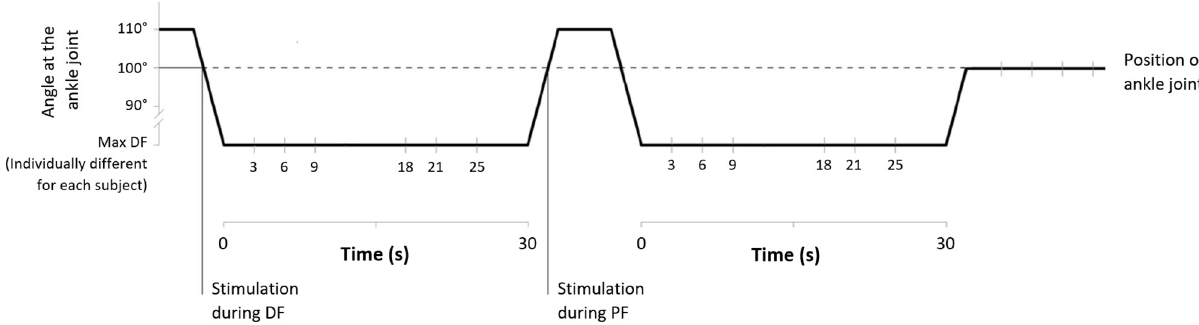
Fig 1. Stretching protocol and stimulation